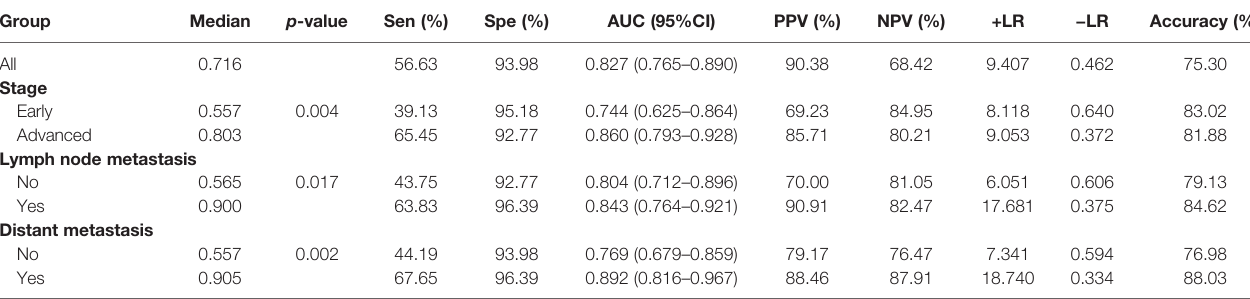
TABLE 3 | Diagnostic value of the model combining fi ve IgM autoantibodies and CEA for LUAD patients with different disease stages.